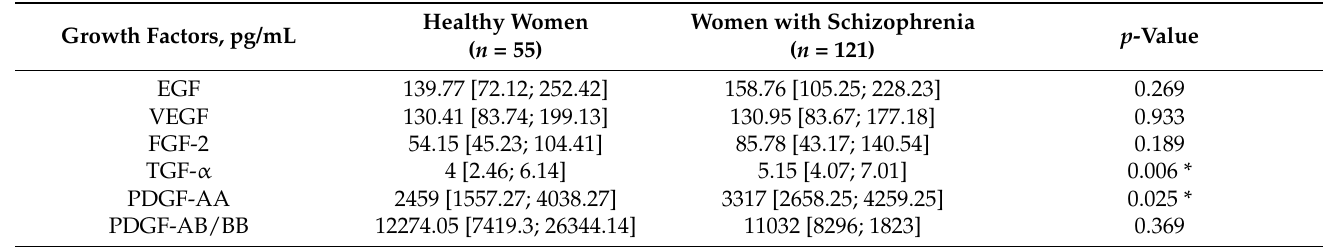
Table 4. Concentration of serum growth factors in female patients with schizophrenia and healthy women (Me [Q1;